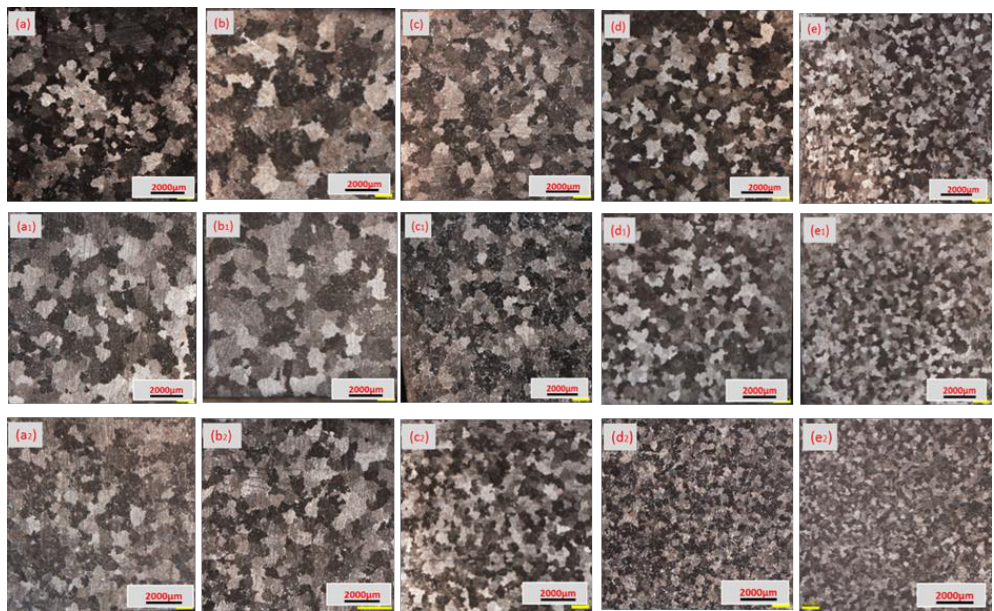
Figure 6. In the regions of the three ingots: ( a – e ) positions of 0R, 0.25R, 0.5R, 0.75R, R of the NO-UTS ingot; ( a 1 – e 1 ) positions of 0R, 0.25R, 0.5R, 0.75R R of I-UTS ingot; ( a 2 – e 2 ) positions of 0R, 0.25R, 0.5R, 0.75R, R of the L-UTS ingot.